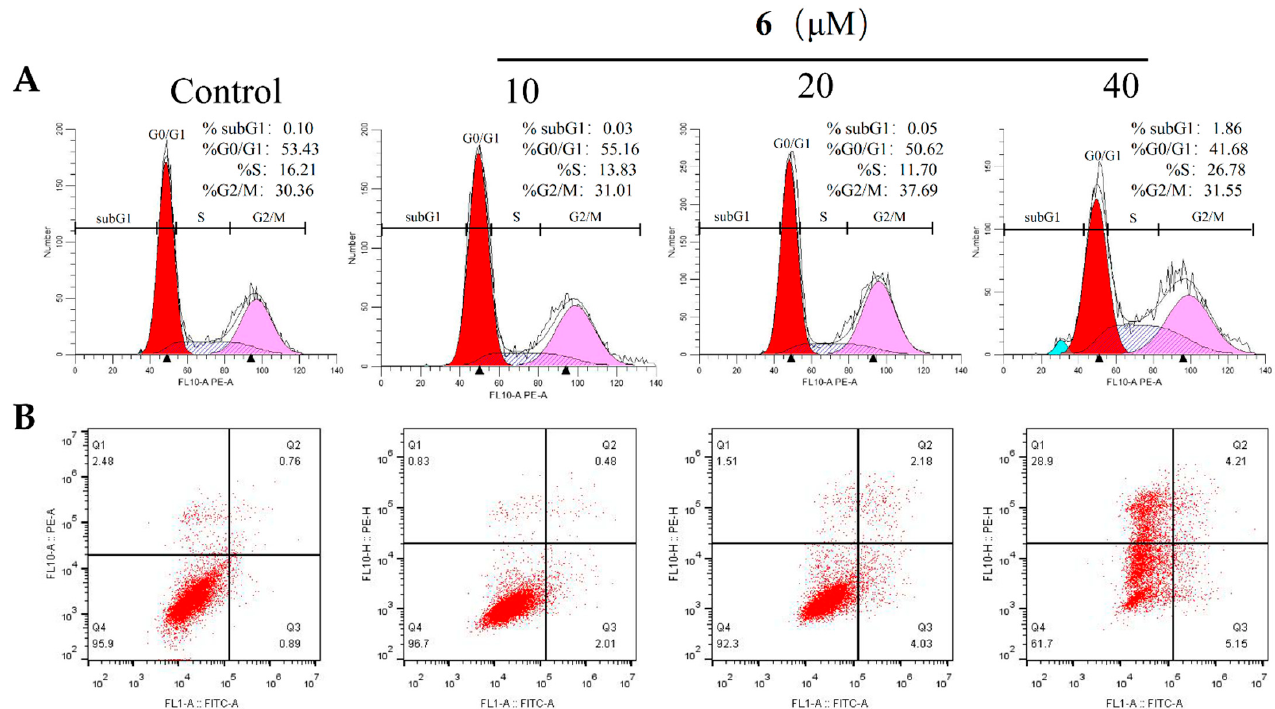
Figure 7. S-phase arrest ( A ) and apoptosis ( B ) of U87 cells induced by 6 for 72 h tested by flow cytometric analysis.